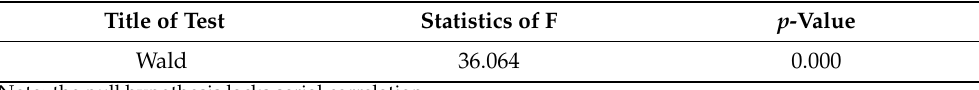
Table 19. The outcomes of the second model serial correlation test.